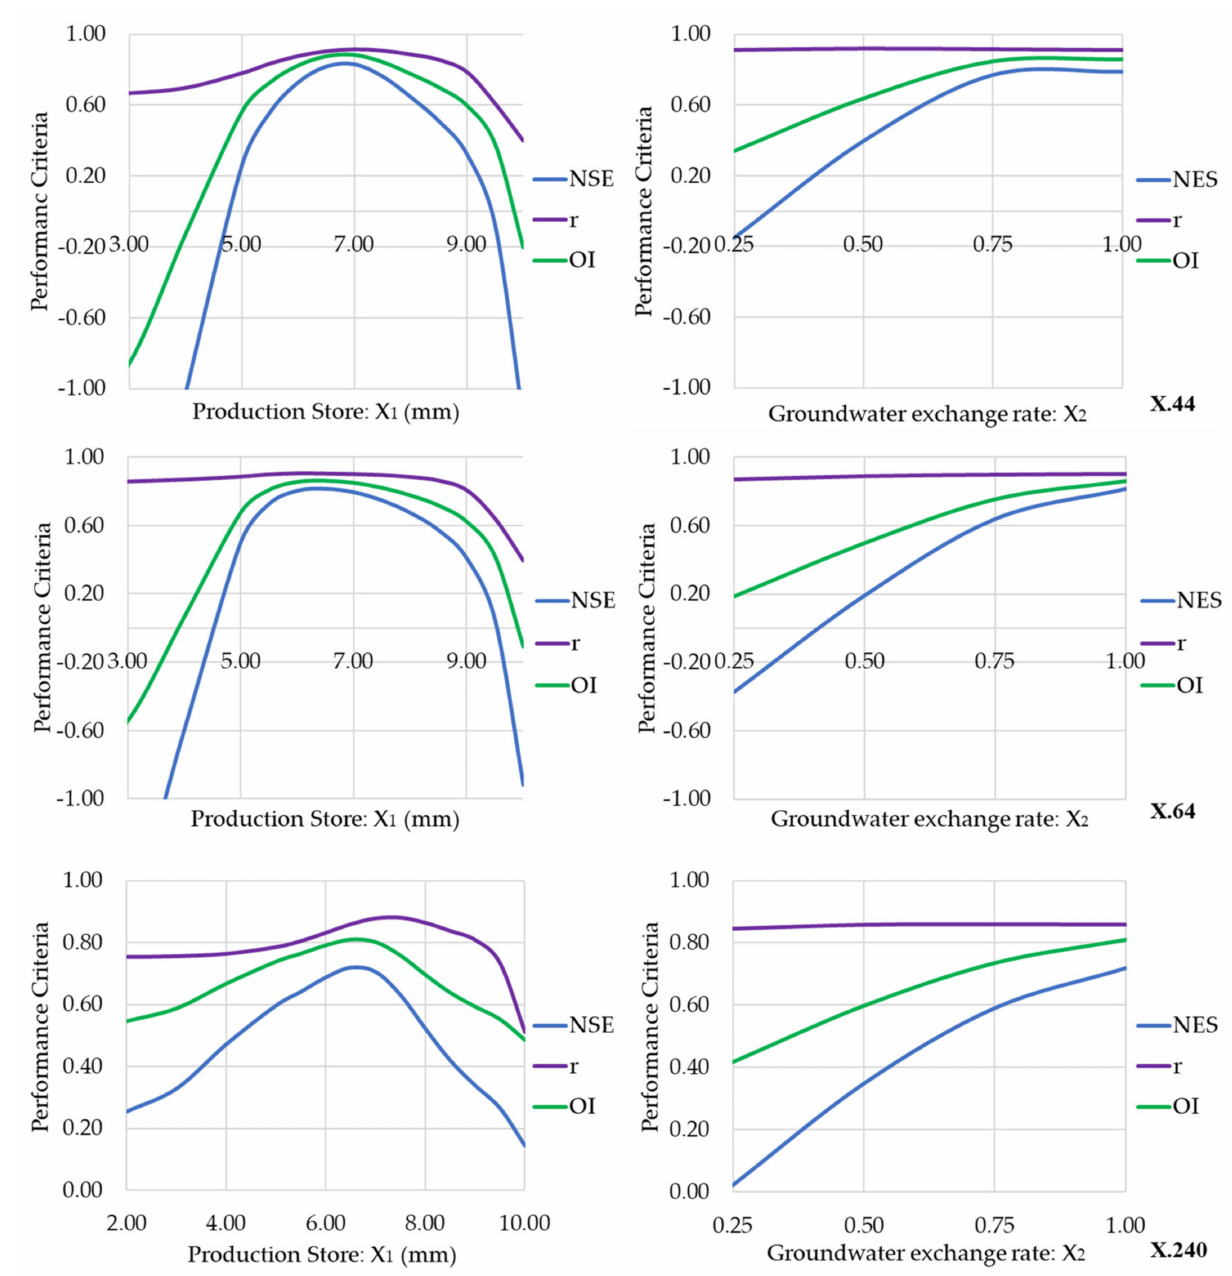
Figure 7. The sensitivity analysis of the GR2M model’s two parameters: X 1 and X 2